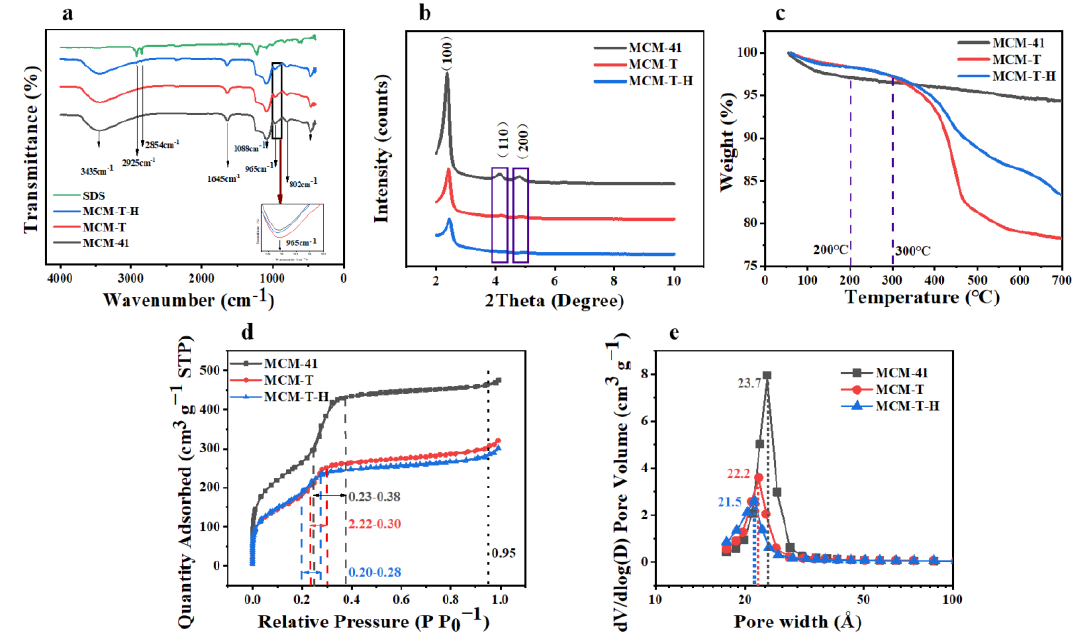
Figure 2. ( a ) FTIR spectra of MCM − 41, MCM − T, MCM − T − H, and SDS; ( b ) XRD spectra of MCM − 41, MCM − T, and MCM − T − H; ( c ) TGA patterns of MCM − 41, MCM − T, and MCM − T − H; ( d ) nitrogen adsorption–desorption isotherms of MCM − 41, MCM − T, and MCM − T − H; and ( e ) pore size distribution of MCM − 41, MCM − T, and MCM − T − H.